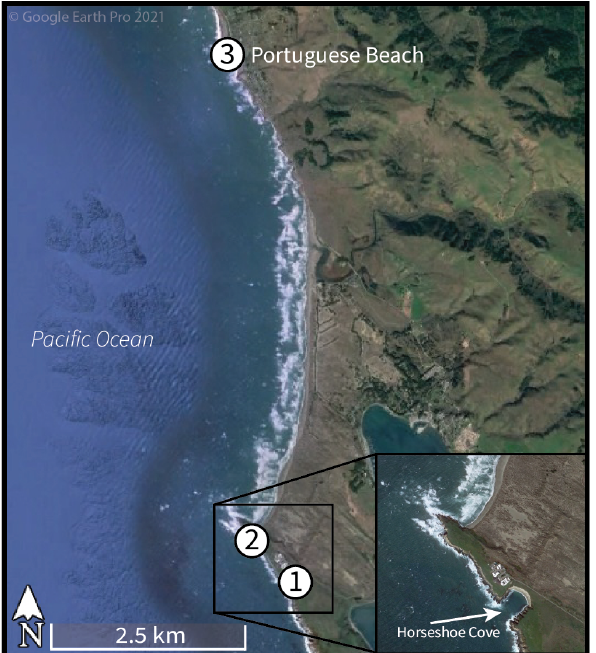
Figure 1. Intertidal collection sites at Bodega Bay, California, along Sonoma Coast. Sites 1 and 2 are located within Bodega Marine Re- serve, and site 3 is located at Portuguese Beach. Modern shells were collected alive in 2019 and 2020 at sites 1 and 2 (Horseshoe Cove and the open-coast site, respectively). Archival shells were collected alive 7km north at Portuguese Beach in 2002 and 2003. © Google Earth Pro 2021.